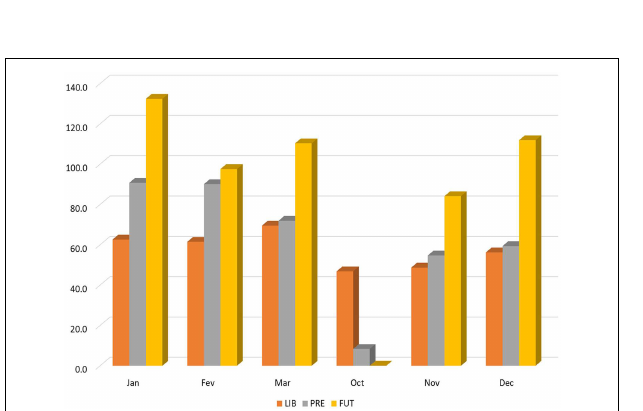
FIGURE 9 | SACZ event percentage from November to March for future